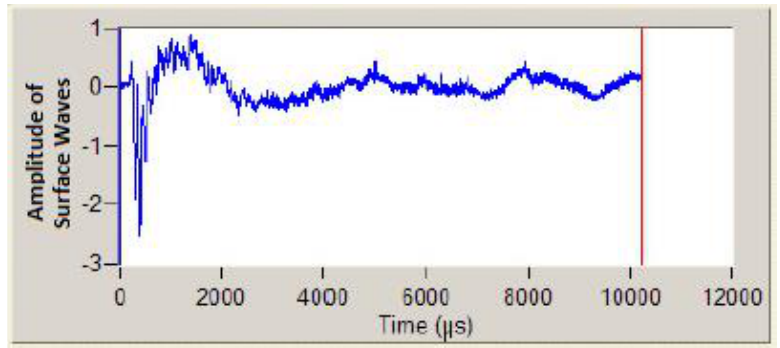
Figure 10. Typical time histories from SASW test (Olsoninstruments,